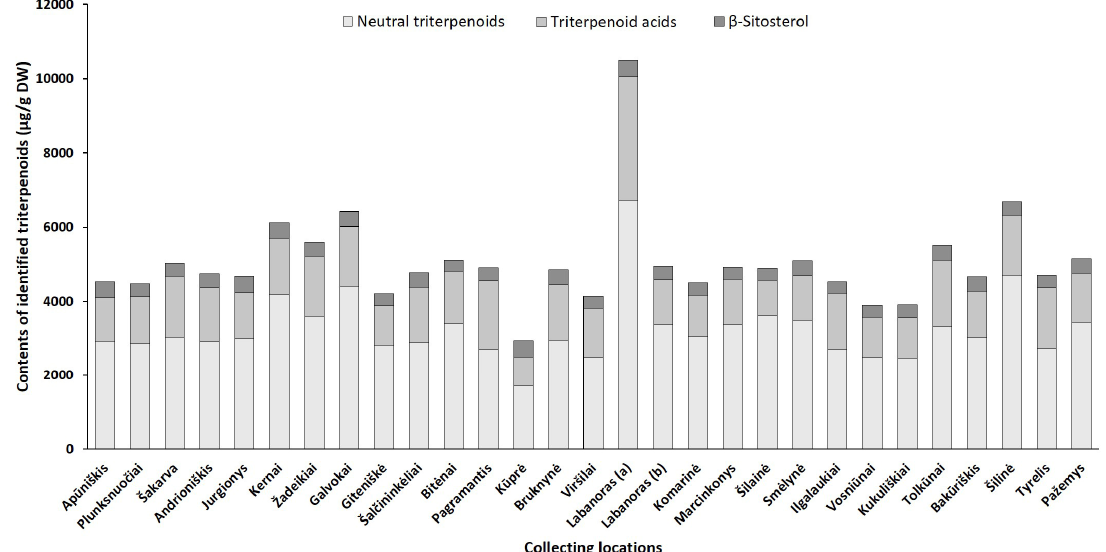
Figure 6. Sum contents of triterpenoids ( μ g/g DW) in lingonberry leaves, collected in different